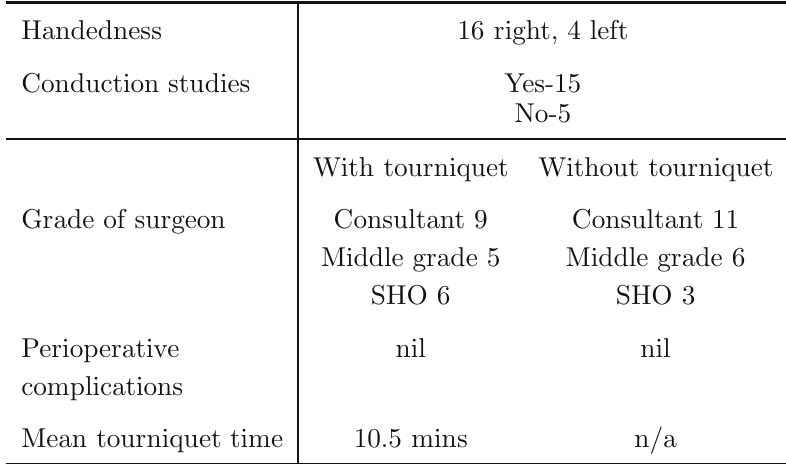
Table 1 Table comparing grade of surgeon in carpal tunnel syndrome with tourniquet and without tourniquet.